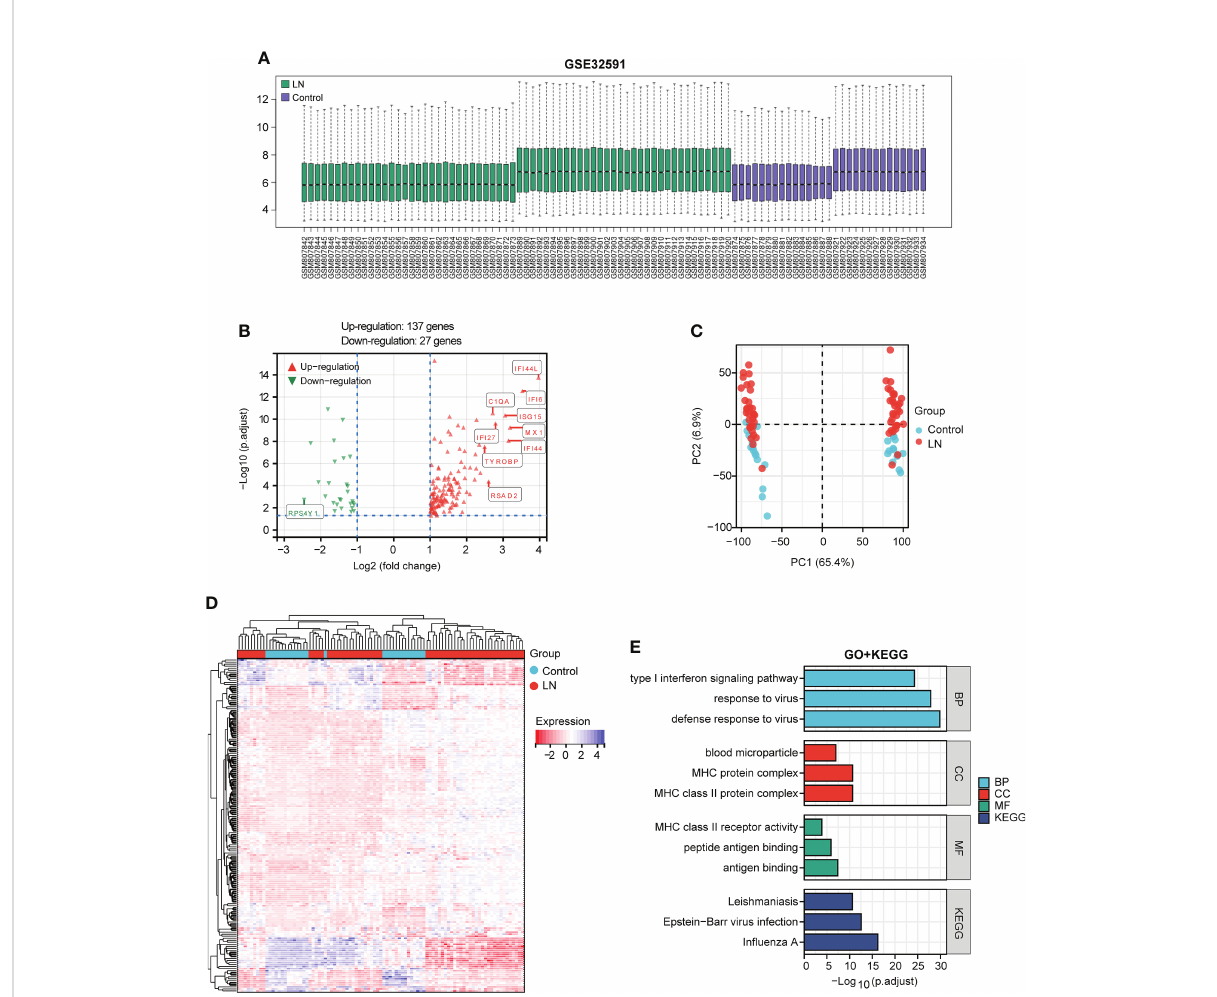
FIGURE 2 Identi fi cation of DEGs between the LN sample and control groups in the GSE32591 dataset and function enrichment analysis. (A) Box plot displaying gene probe expression levels. (B) Volcano plot of DEGs between LN patients and controls. The top 10 differentially expressed genes are marked on the plot. (C) PCA of the samples. (D) Expression heatmap of all screened DEGs. (E) GO and KEGG enrichment analyses of